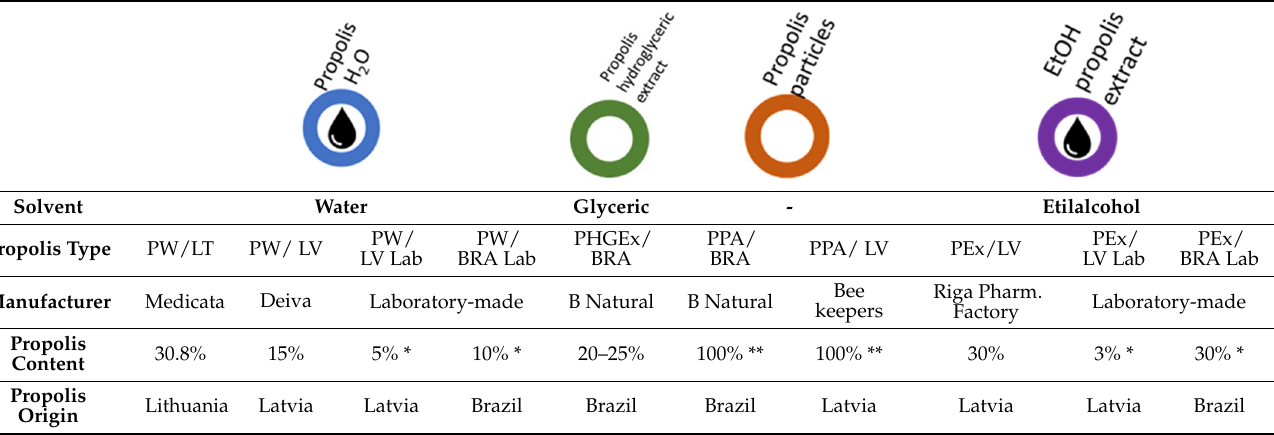
Table 7. Data of propolis and its extracts.